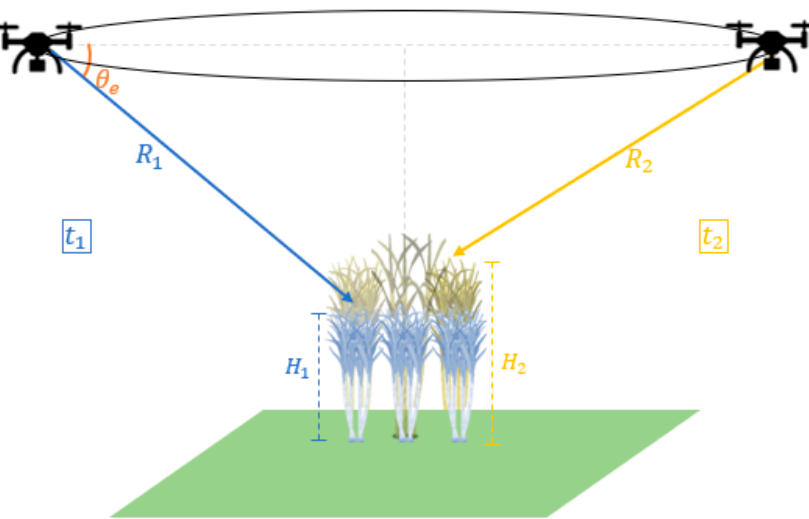
Figure 2. DInSAR circular flight pattern and illumination geometry.